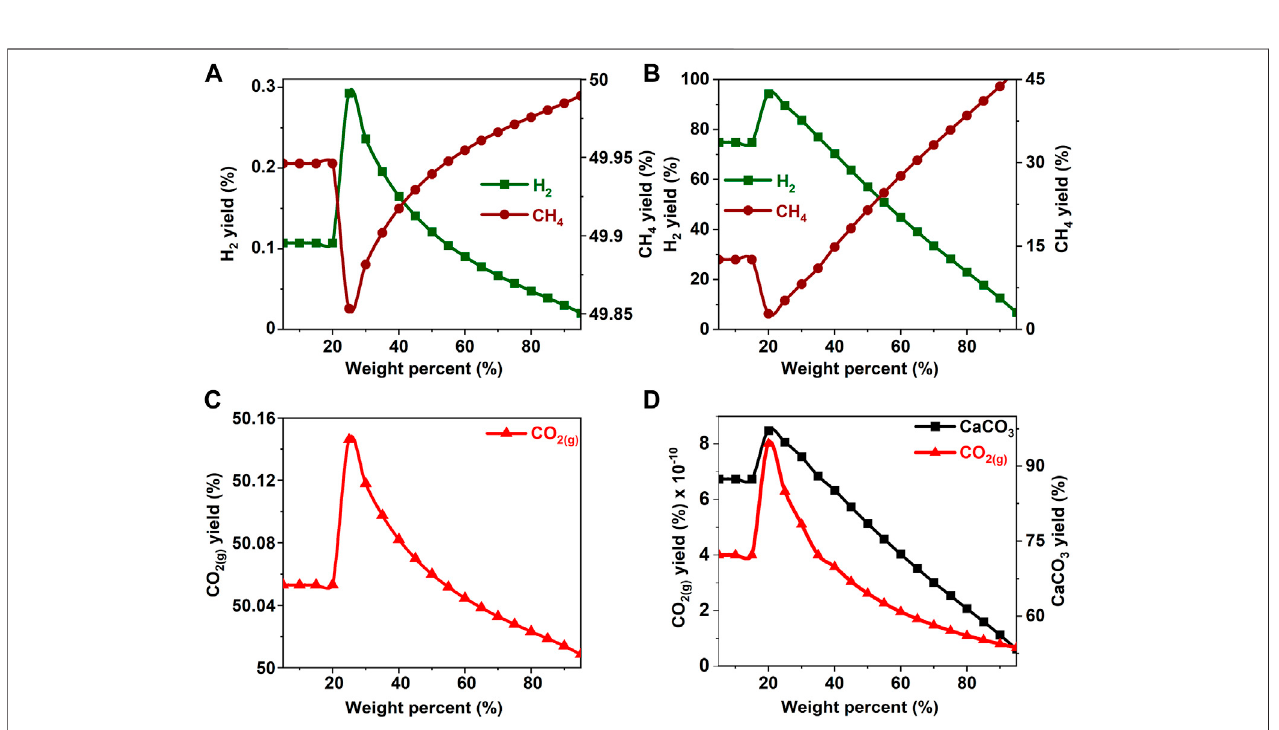
FIGURE8| Effect ofacetic acidconcentrationontheproductyield (A , C) intheabsenceand (B) inthepresenceofcalciumoxide.TheyieldofCO 2 postcaptureto produce calcium carbonate is represented in 6 (D) . These calculations are performed with temperatures of 227 ° C and pressures of 50 bar.